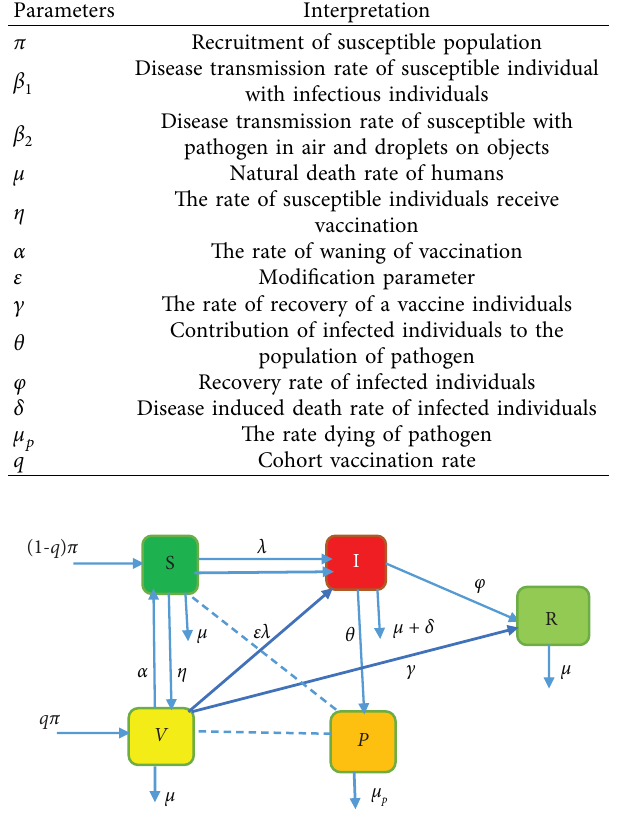
Figure 1: Compartmental model of measles disease transmission fow